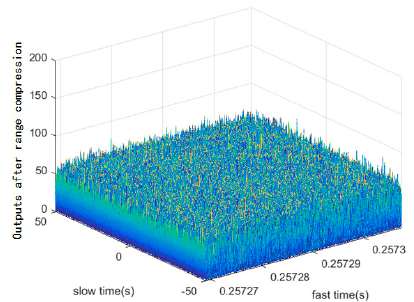
Figure 7. Outputs of signal data after the range compression.